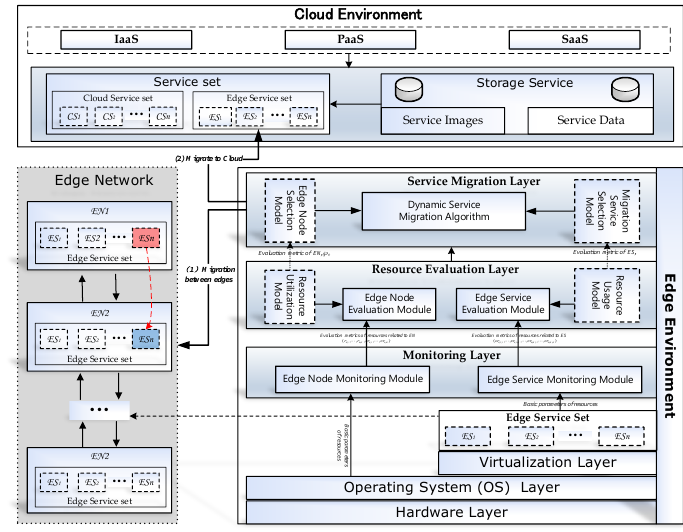
Figure 1. The framework of smart service